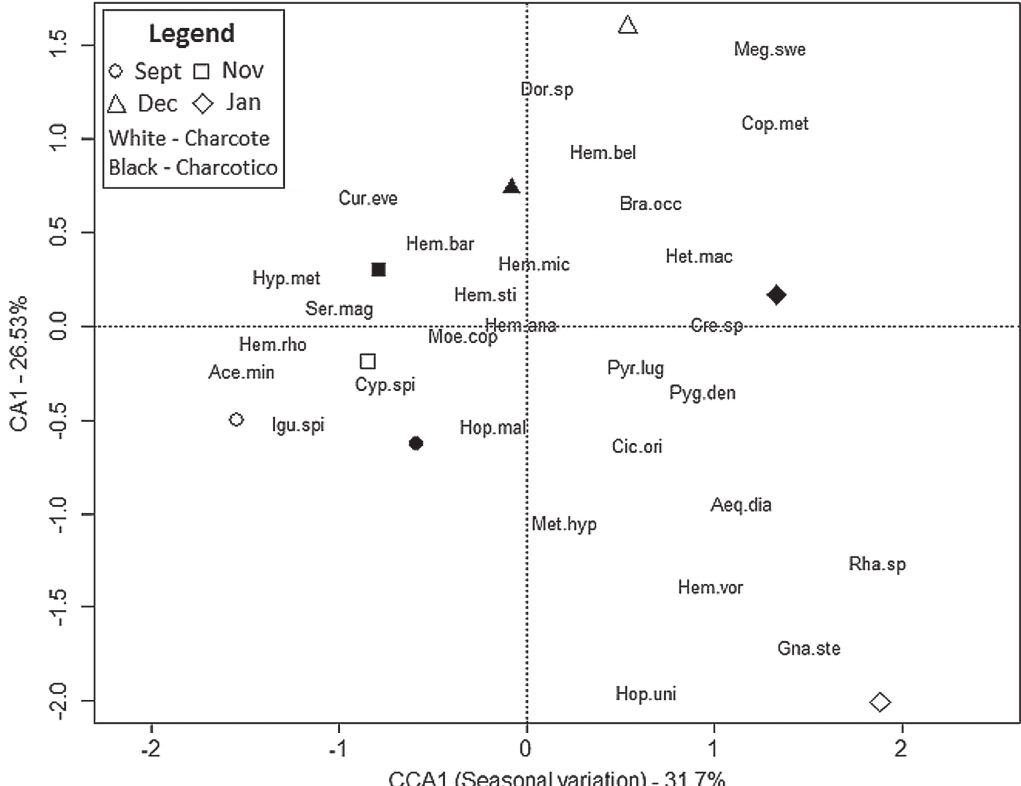
Fig. 2. Canonical Correspondence Analysis (CCA) for the fish assemblage structure sampled during four months (symbols) in the Charcote (white) and Charcotico (black) streams. Only species with more than 0.5 % of abundance were included in this analysis. For graphical purposes, we are only showing species that had a goodness-of-fit larger than 0.1. A list with species’ abbreviations and species and sites scores can be found in ( S2 - Available only as online supplementary file accessed with the online version of the article at http://www.scielo.br/ni). The low-water period is represented by January, high water by September, and falling water by November and